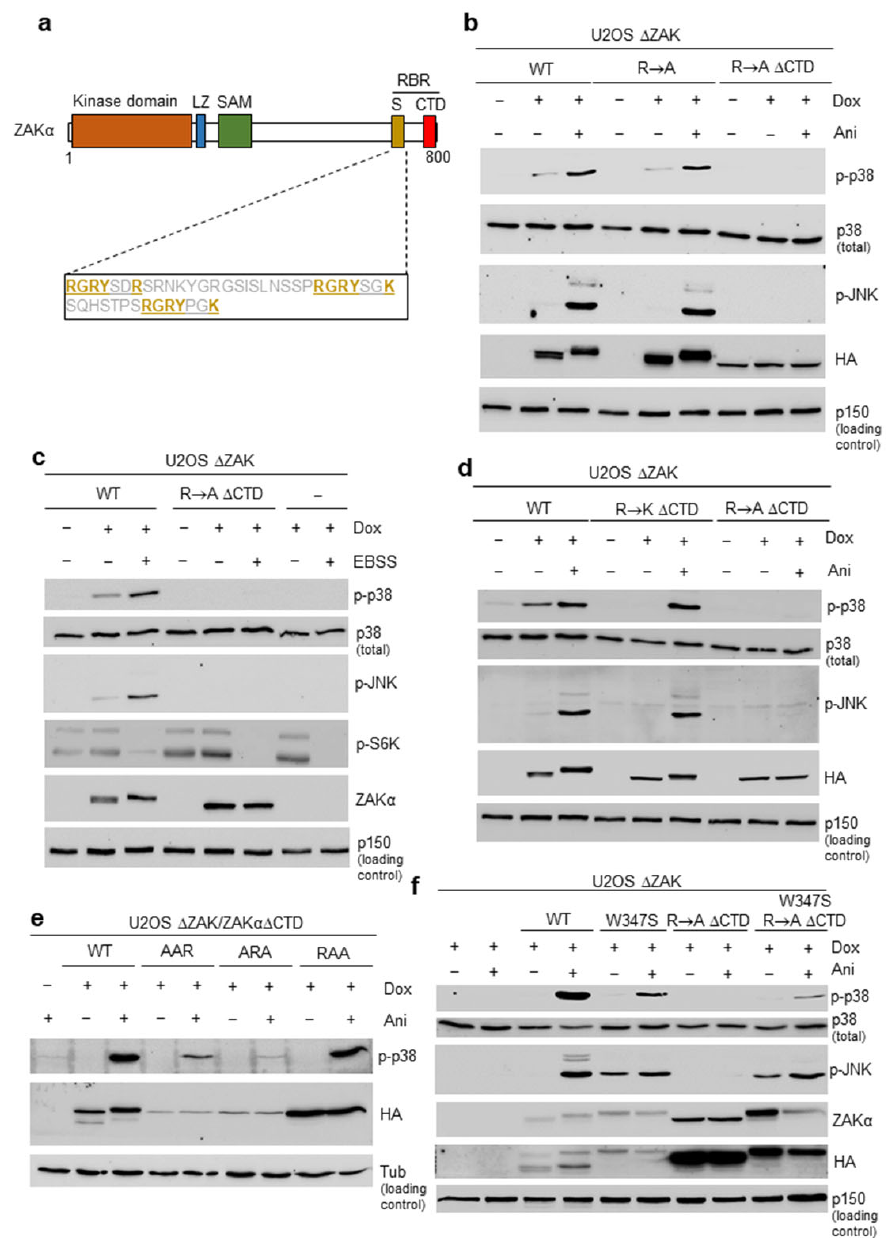
Figure Figure 1. Redundant peptide arrays underlie functionality of the sensor domain in ZAK α . ( a ) Schematic of the ZAK α protein highlighting the three RGRYXXR/K motifs in the sensor (S) domain. ZAK α S domain mutants used in this study are detailed in Figure S1a. LZ, Leucine Zipper; SAM, Sterile Alpha Motif; S, Sensor Domain; CTD, C-Terminal Domain; and RBR, Ribosome Binding